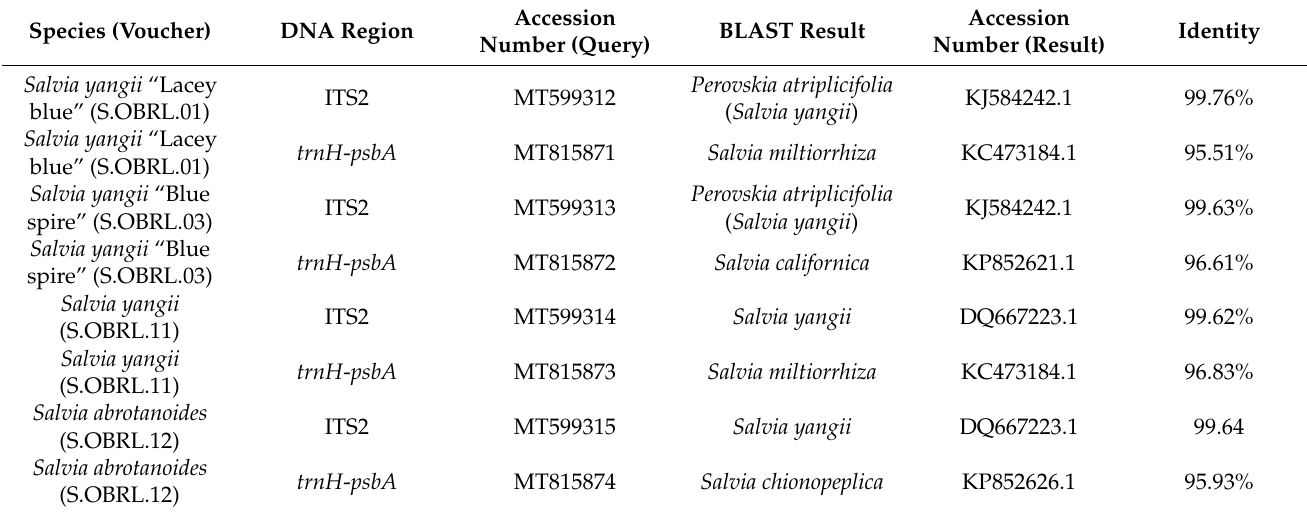
Table 4. Results of BLAST